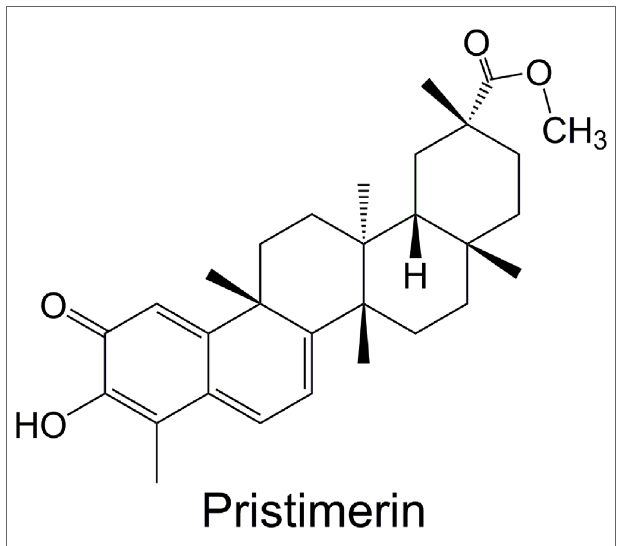
FIGURE 1 | Chemical structure of